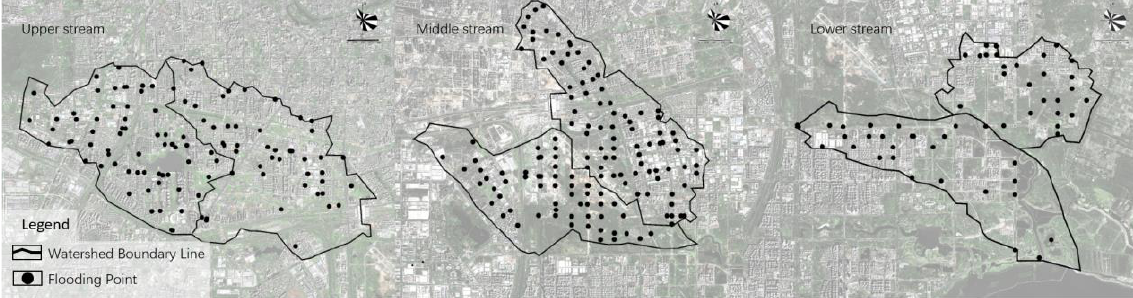
Figure 3. The distribution of overflow nodes with overflows exceeding 5 × 10 4 m 3 .